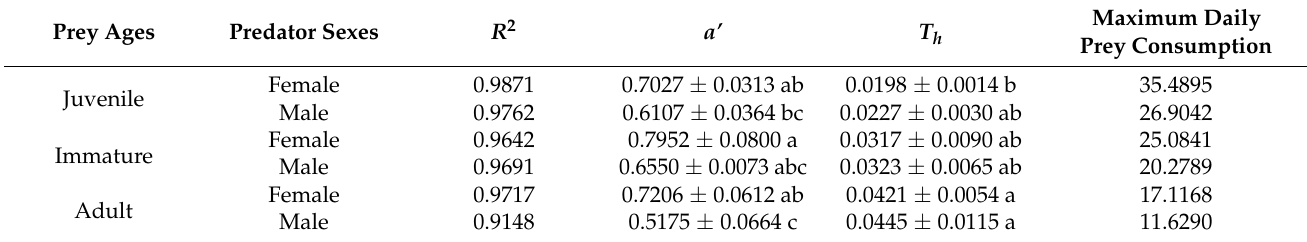
Table 1. Functional responses of C. elysii adults to distinct sizes of A. agrestis .